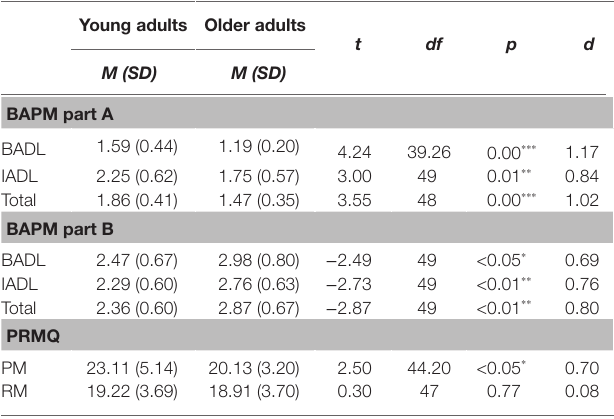
TABLE 2 | Descriptive and inferential statistics for self-reported data in young adults ( n = 28) and older adults ( n = 23). Young adults Older adults